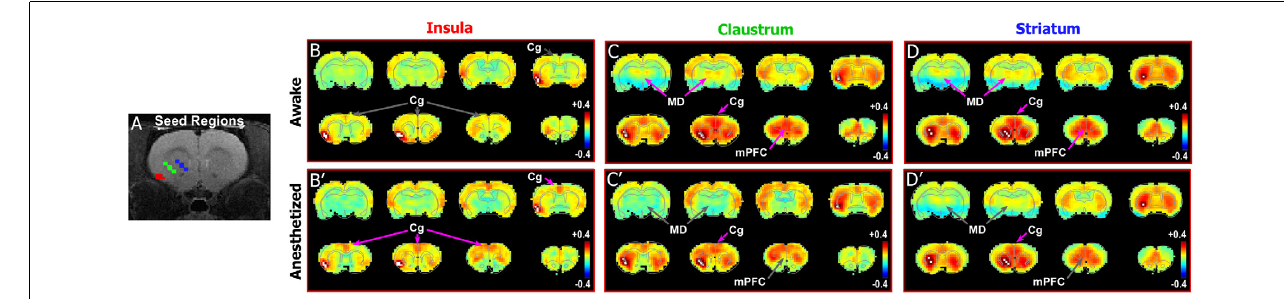
FIGURE 4 | Differences in functional connectivity between striatum, claustrum, and insula. (A) Seed regions for insula (red), CLA (green), and striatum (blue) shown on T1-MRI. (B–D (cid:48) ) Correlation maps for insula, CLA, and striatum in awake state (top panels) and anesthetized states (bottom panels). Striatum and CLA had highly similar patterns of connectivity with strong connections to Cg cortex and MD thalamus in the awake state, whereas insula was only functionally connected with Cg cortexin the anesthetized state. Data modified with permission from Smith et al.